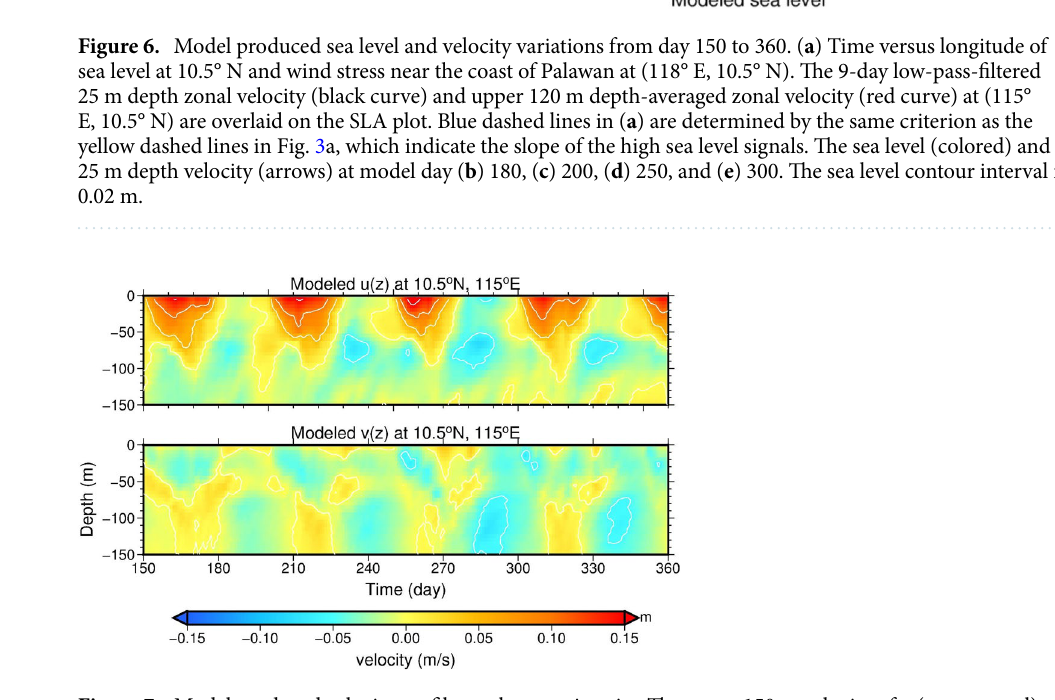
Figure 7. Model produced velocity profiles at the mooring site. The upper 150 m velocity of u (upper panel) and v (lower panel) at grid (115° E, 10.5° N) where is close to the ADCP mooring